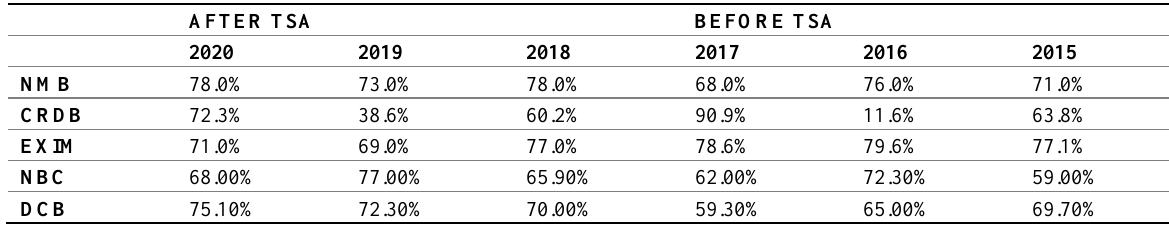
Table 7: Liquidity (Loan-to-Deposit